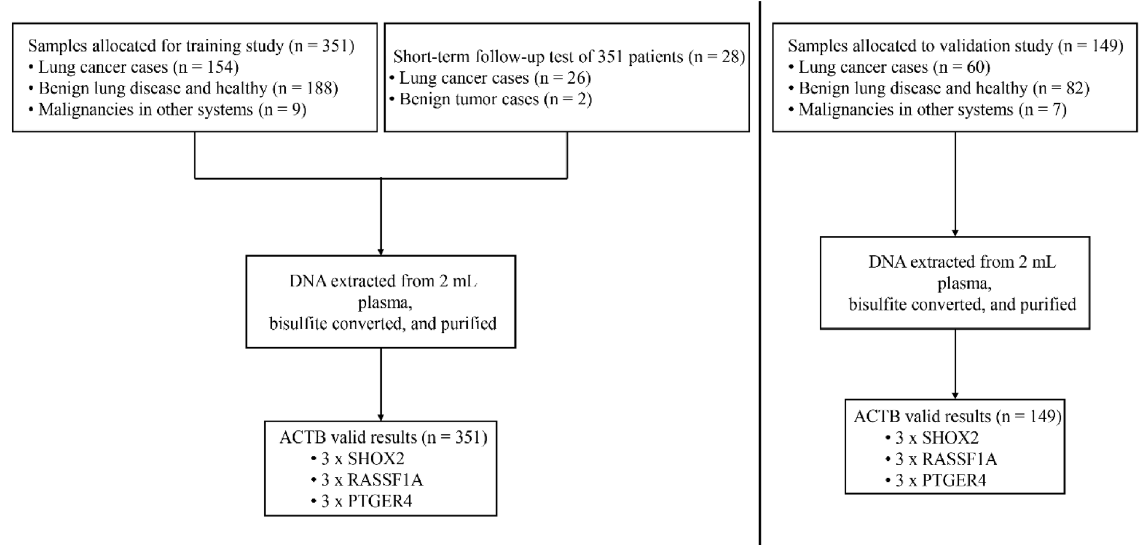
Figure 1. Sample disposition, study setup, and polymerase chain reaction (PCR) assay formats. Boxes in the bottom line indicate number of valid results and number of PCR replicates per PCR assay. For more details,